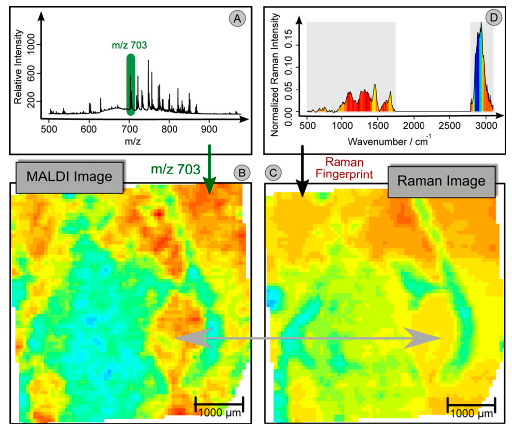
Figure 4. Workflow of Quantitative Correlation. ( A ) Mean MALDI spectrum of the (Raman) scanned region. ( B ) Integrating a peak region ( m / z 703) leads to a false-color image, which can be interpreted as a chemical map. ( C ) By multivariate calibration methods, a model can be constructed, which translates a MALDI peak into a complex Raman signature. Here we used a PLS-model to construct a model for the MALDI marker of gray matter ( m / z 703). The Raman signature can then be applied on sections without applying the MALDI imaging. This allows the use of information associated with the MALDI marker of gray matter ( m / z 703) under noninvasive conditions or together with a contrary MALDI matrix. ( D ) The mean Raman spectrum of the region is given. The color inside the spectrum represents the translated Raman marker of gray matter. The Raman signature corresponds to the weights of the PLS-model, which was used to construct (C). Peaks which are red are mostly expressed in regions, where (B, C) show high values (red). On the other hand, the blue area in the CH-wavenumber region of (D) is related to the blue and green region of (B, C). Reprinted with permission from Bocklitz et al.,